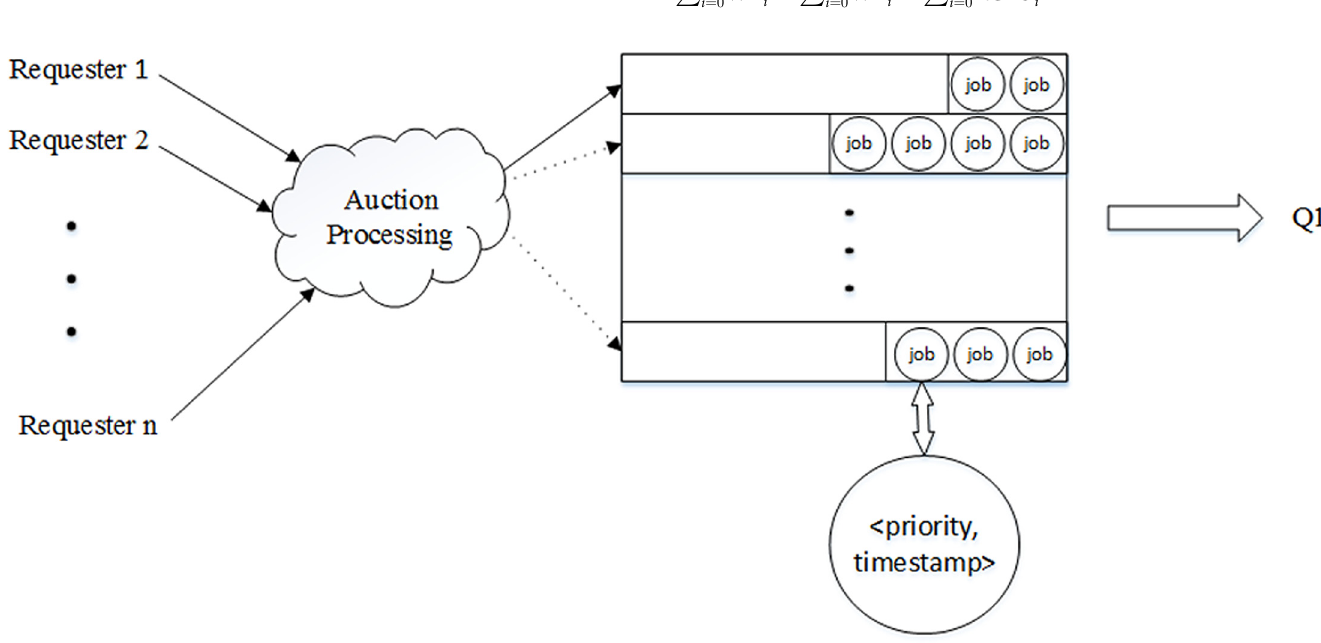
Fig 3. A detailed description of dynamic priority queue. Through auction processing, the winning job obtains the current best position, and enters into corresponding priority queue with timestamp. Then, the job waits for being scanned and inputted in Q 1 .